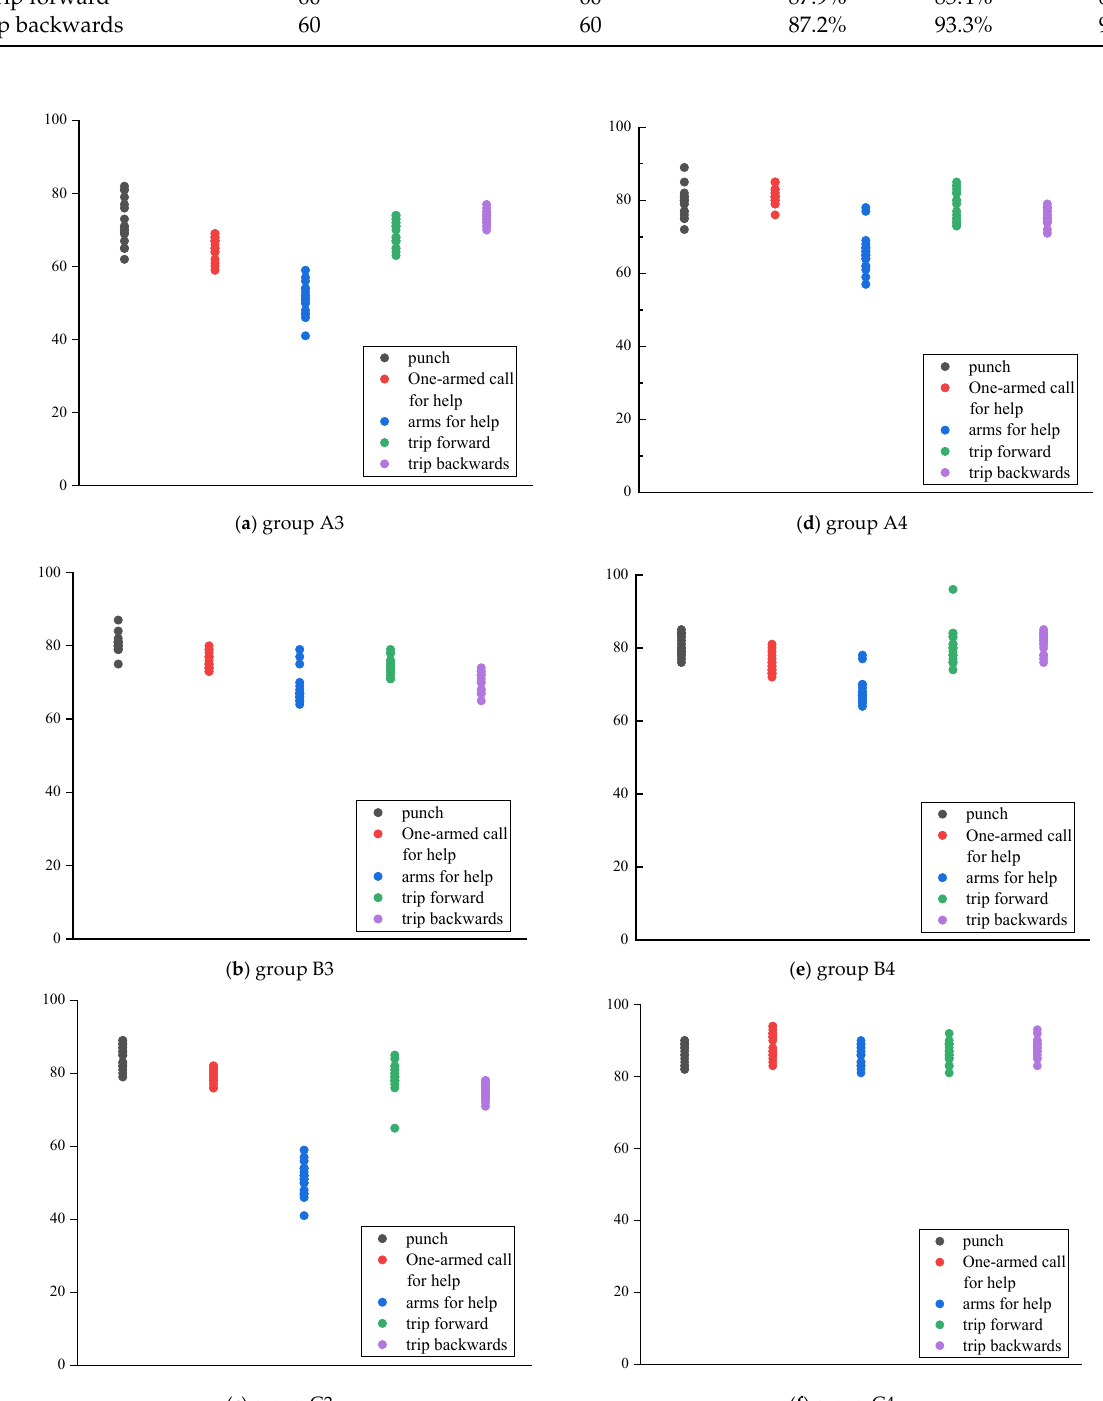
Figure 12. Result of local joint selection. Table 9. Local “adjacent joint method” identification results.